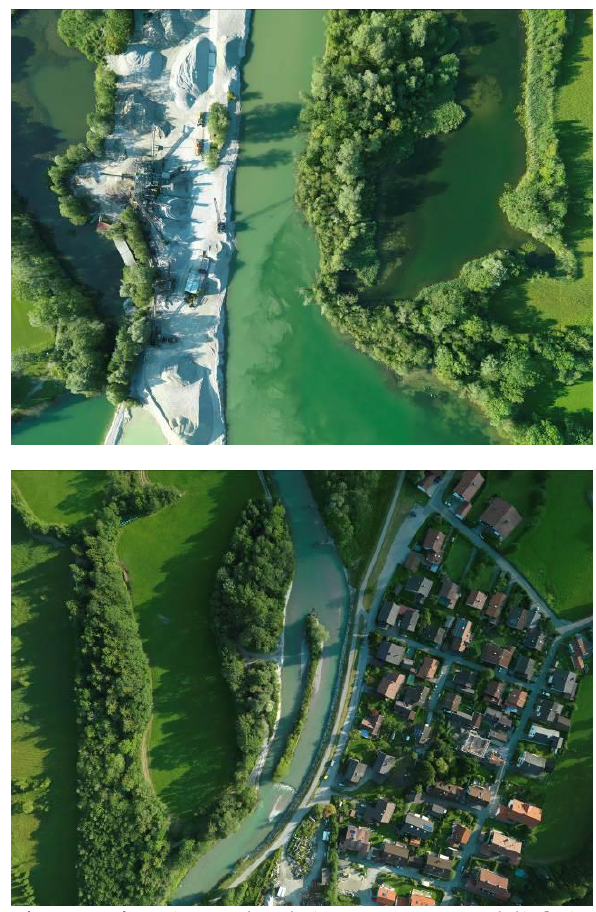
Figure 4 and 5: Pictures taken during survey process and displaying the estuary of River Loisach into Lake Kochel and the river within a flood protection relevant area.